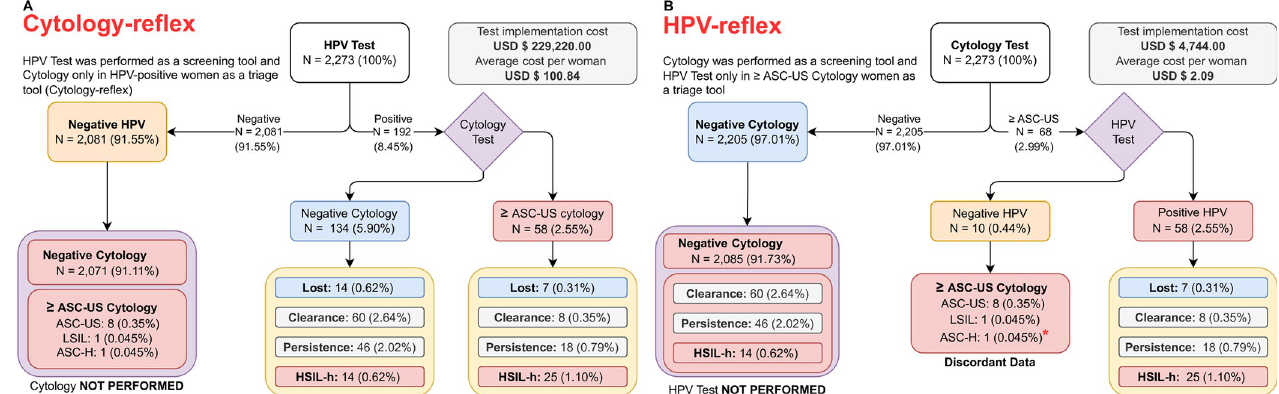
Fig 6. Cervical cancer screening via reflex algorithm. A) cytology-reflex B) Human Papillomavirus (HPV)-reflex. Clinician time, reagent, and pathological test equivalent to 12% of the molecular methods (USD$250), thus the costs of "clinical interventions" were not considered because, in our country, they are negligible in comparison to molecular